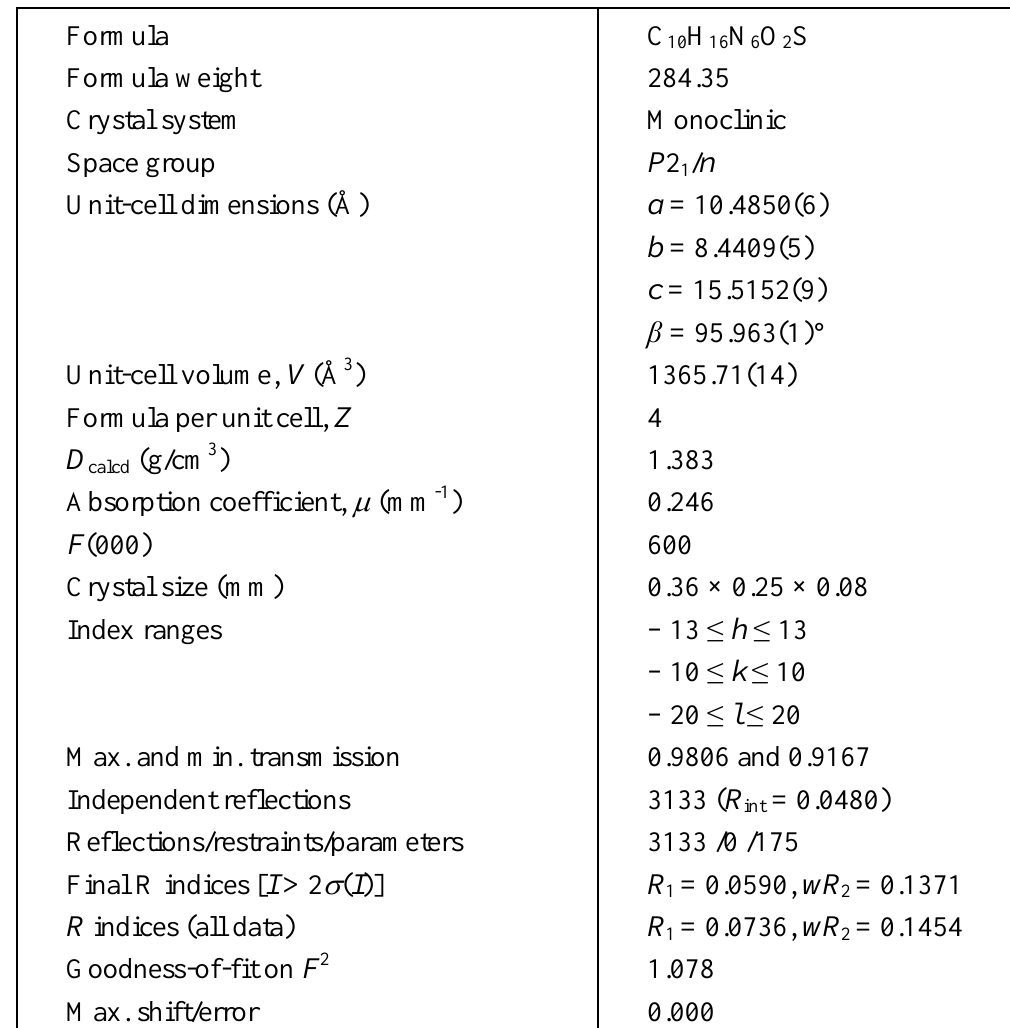
Table 2. Crystal and experimental data for compound